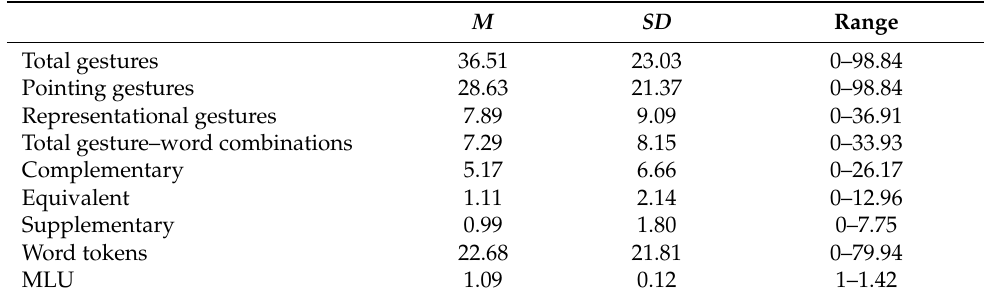
Table 2. Descriptive statistics of late talkers’ gestures, gesture–word combinations, word tokens, and MLU, during the 10-min parent–child book-sharing